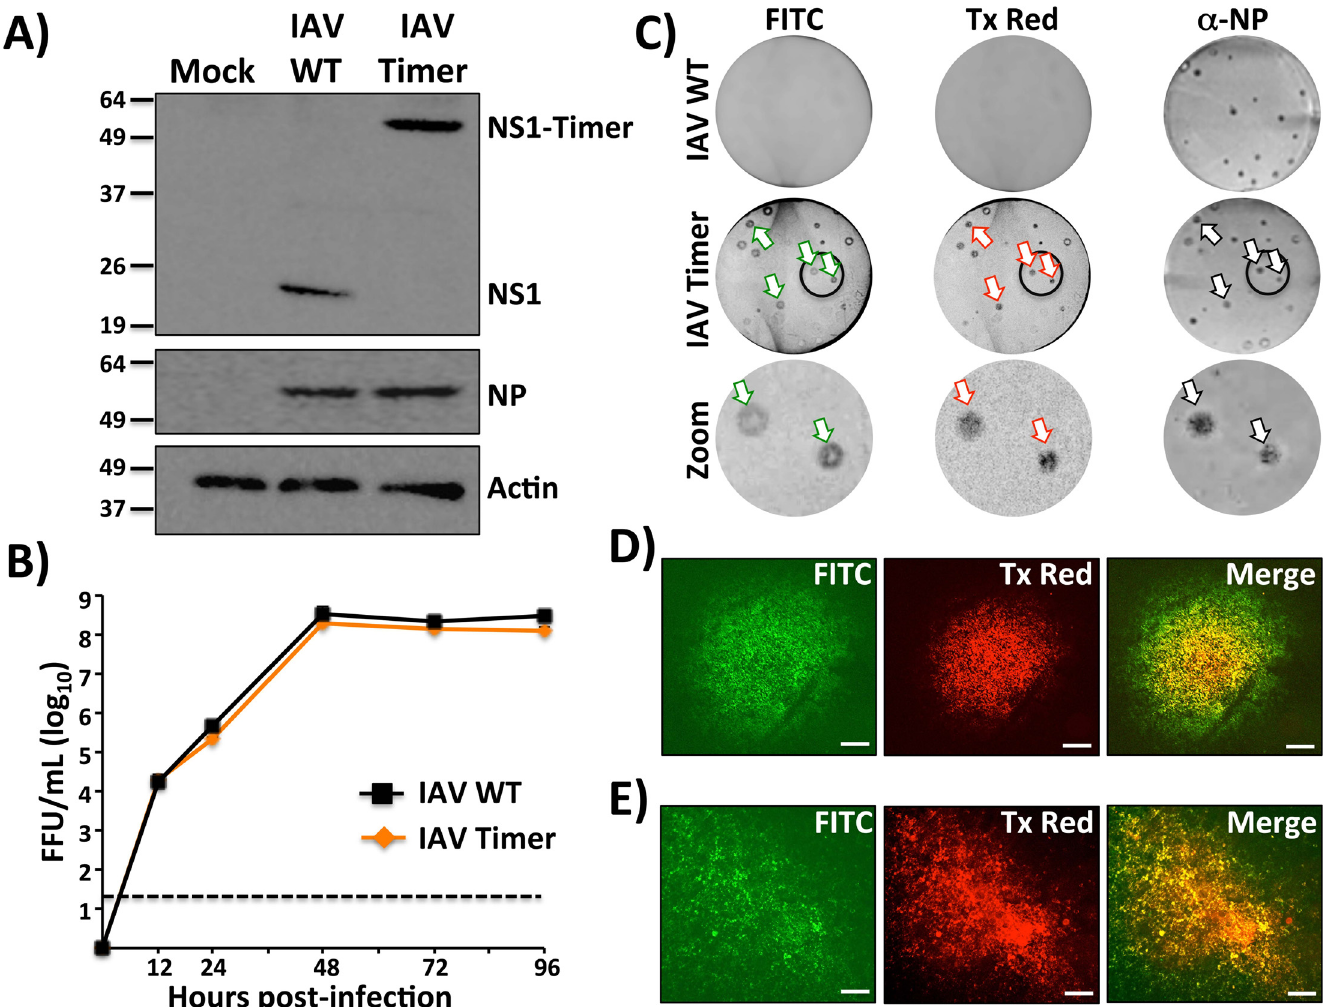
Fig 2. Characterization of Timer-expressing IAV. A) Analysis of protein expression by Western blot: MDCK cells were mock infected or infected (MOI 3) with WT or Timer-expressing IAVs. At 24 hpi, cell extracts were prepared and analyzed for NS1 and NP expression levels using specific antibodies. Actin was used as a loading control. Numbers indicate the size of molecular markers in kDa. B) Multicycle growth kinetics: Viral titers from TCS of MDCK cells infected (MOI 0.001) with WT and Timer-expressing IAVs at the indicated times (0, 12, 24, 48, 72 and 96 hours) were analyzed by immunofocus assay (FFU/ml). Data represent the means ± SD of the results determined from triplicates. Dotted line indicates the limit of detection (20 FFU/ml). C) Plaque phenotype: WT and Timer-expressing IAV plaques were evaluated at 3 dpi by fluorescence using filters for fluorescein isothiocyanate (FITC) or Texas Red (Tx Red) and by immunostaining using an IAV anti-NP MAb. Arrows indicate correlation between fluorescence and the immunostaining. A zoom of the areas into the black circles for IAV-Timer is showed. “ Bull ’ s eye ” plaque (D) and “ comet tail ” (E) assays: Monolayers of MDCK cells were infected (MOI 0.001) with IAV-Timer and covered with solid (D) or liquid (E) media. At 72 hours post-infection, infected cells were visualized using filters for FITC and Tx Red. Merged images are showed. Scale bar, 200 μ